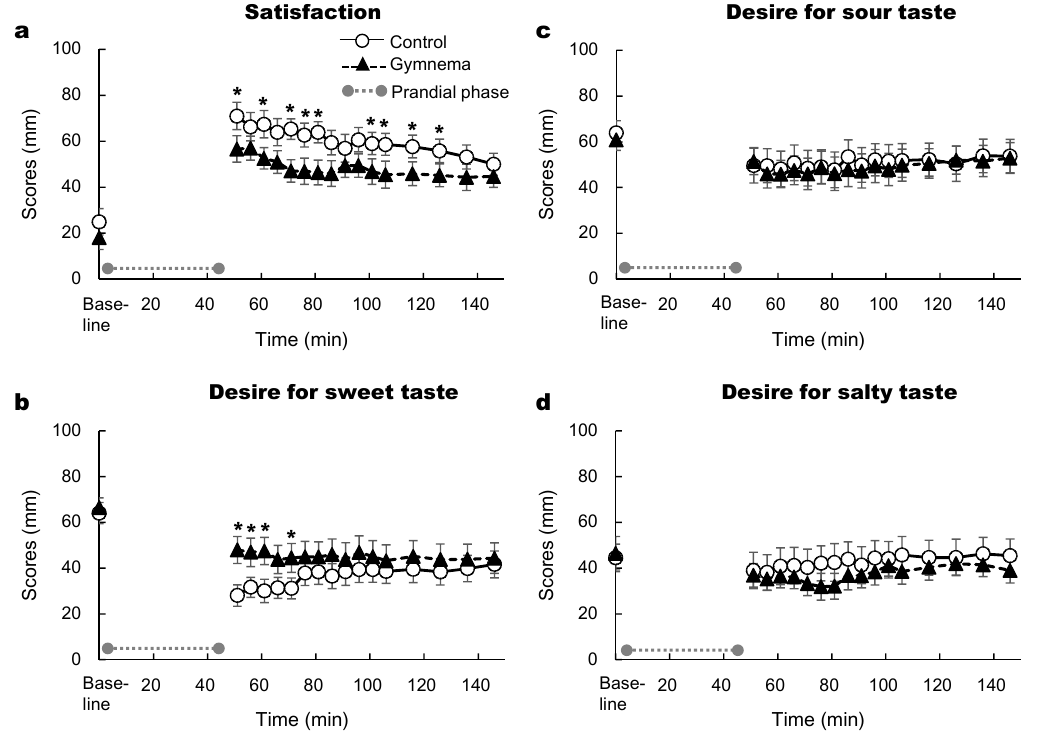
Figure 6. Time courses of satisfaction ( a ) and desire for sweet ( b ), sour ( c ) and salty ( d ) tastes after consuming sweet-tasting foods. Mean ± SE. Grey circles at both ends of the dotted gray line denote the limits of the prandial phase (consumption of sweet-tasting food). *: p < 0.05 between the two pretreatments.